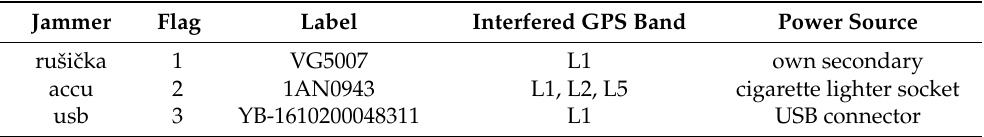
Table 2. Some basic characteristics of the jammers used in the experiment.